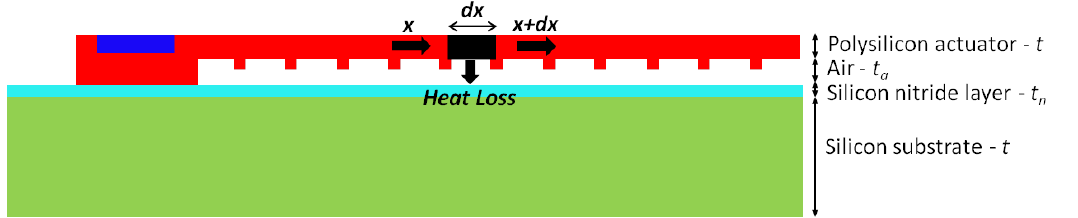
Figure 7. Cross-section of the actuator for the 1D thermal analysis (not-to-scale), illustrating the differential element used to derive the heat flow